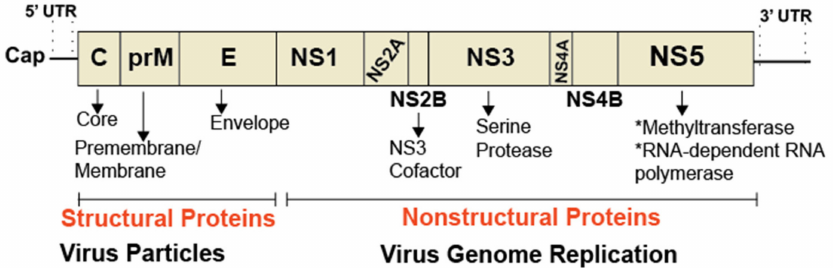
Figure 3. Organization of a flavivirus genome. The genome of flaviviruses, such as dengue and Zika, is ~11 kb in size and encodes a single, large polyprotein, which is proteolytically processed into three structural proteins and seven nonstructural proteins. The 5’ end of the genome contains a cap structure critical for the initiation of translation. RNA structures present in the 5’ and 3’ untranslated regions (UTR) are critical for capping and genome